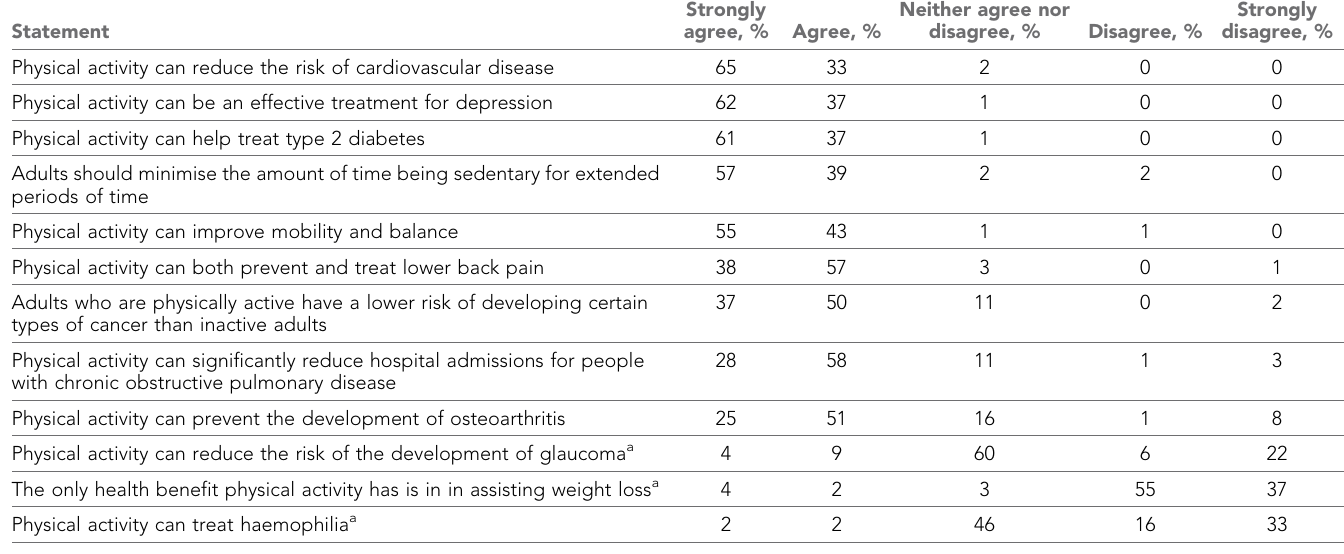
Table 5. Displaying the proportion agreeing/disagreeing with statements about physical activity and health outcomes